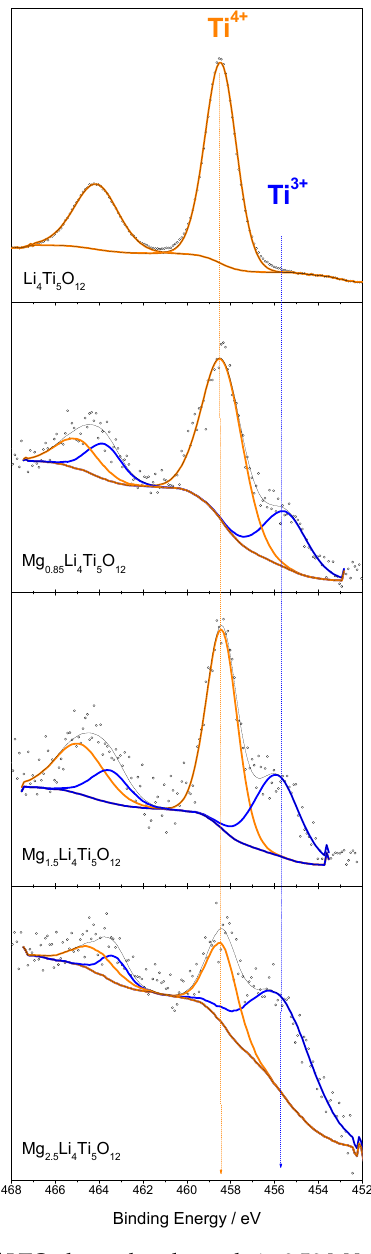
Figure 7. Ex-situ XPS spectra of LTO electrodes electrode in 0.50 M Mg(TFSI) 2 + 0.13 M MgCl 2 · 6H 2 O in DME as electrolyte at x = 0, 0.85, 1.5, and 2.5 (x in Mg x Li 4 Ti 5 O 12 ) which correspond to 0, 100, 175 and 290 mA h g − 1 capacity, respectively.